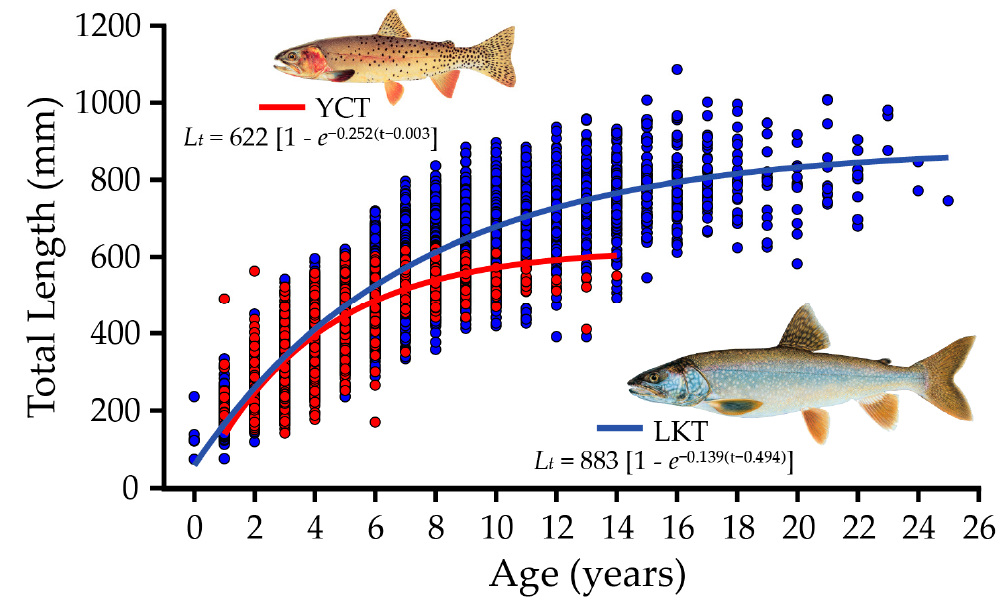
Figure 3. Total lengths-at-age ( L t ) of native cutthroat trout (YCT; n = 1350) and invasive lake trout (LKT; n = 6387) collected by gillnetting on Yellowstone Lake during 1998 to 2019, with von Bertalanffy growth functions. Asymptotic mean lengths of cutthroat trout and lake trout were 622 mm (95% CI: 600–648) and 883 mm (95% CI: 869–898), respectively. Cutthroat trout with a maximum age of 14 years had a mean predicted length of 604 mm and lake trout with a maximum age of 25 years had a mean predicted length of 854